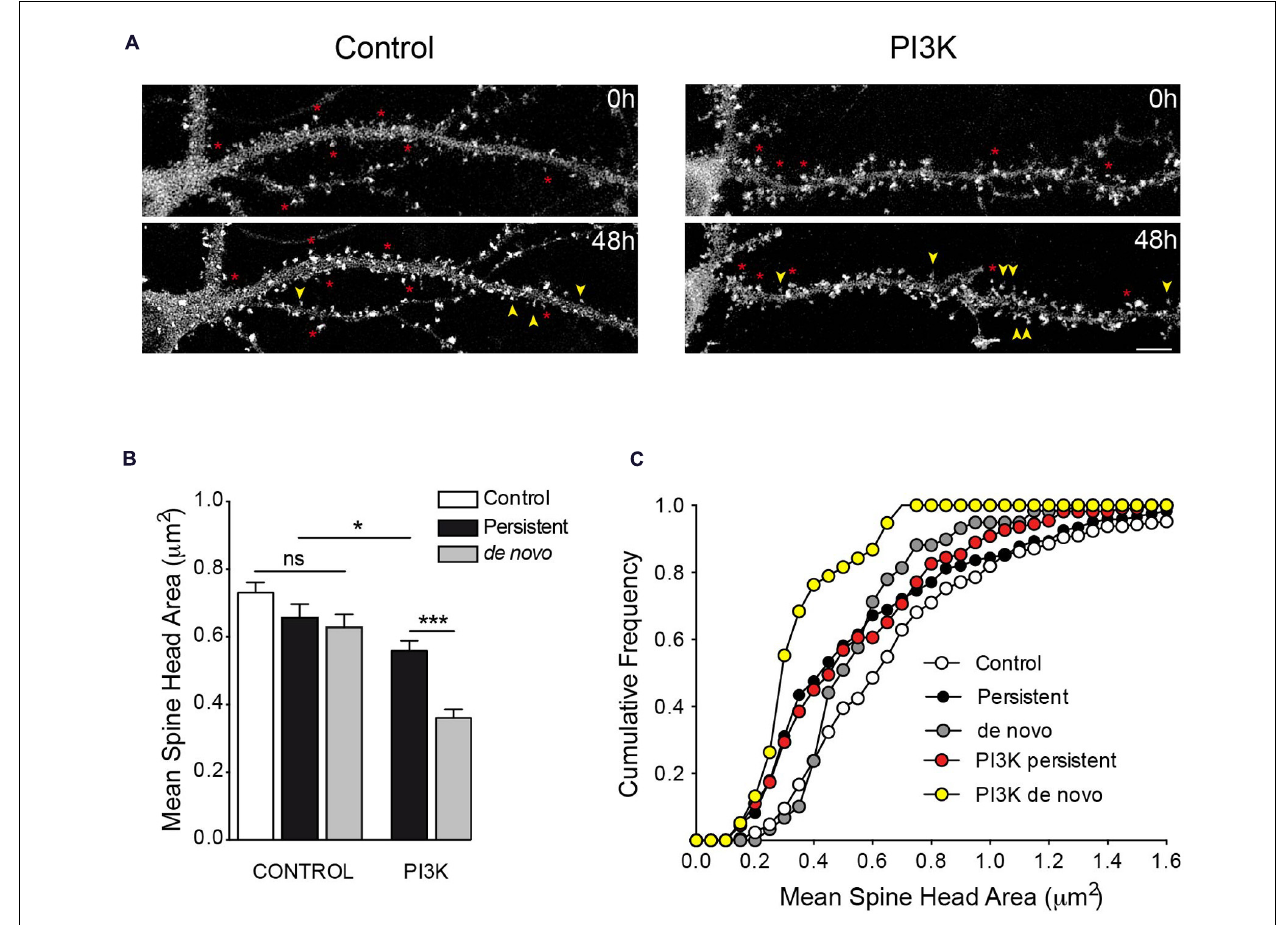
FIGURE 8 |Time lapse analysis of PI3K-induced spines. (A) Representative frames from time lapse videos of hippocampal neurons transfected with actin-GFP in control and after 48 of PTD4-PI3KAc-treated (top and bottom pictures correspond to 19DIV and 21DIV, respectively).Yellow arrows indicate de novo spines, whereas asterisks indicate persistent spines. (B) Bar plot of the mean spine head areas. Under control conditions, there are no significant differences between persistent and de novo spines, although a tendency toward smaller values is evident. After PI3K activation, persistent spines have small size areas compared with control conditions, while the de novo spines were smaller compared to the persistent ones (Student’s t -test).